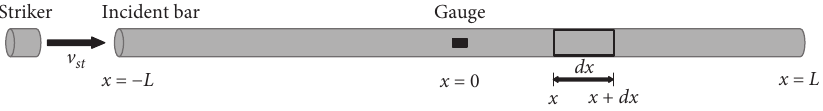
Figure 1: Schematic diagram of a linear viscoelastic bar under